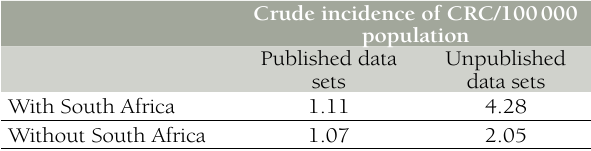
Table 5 Sensitivity analysis of published vs unpublished data